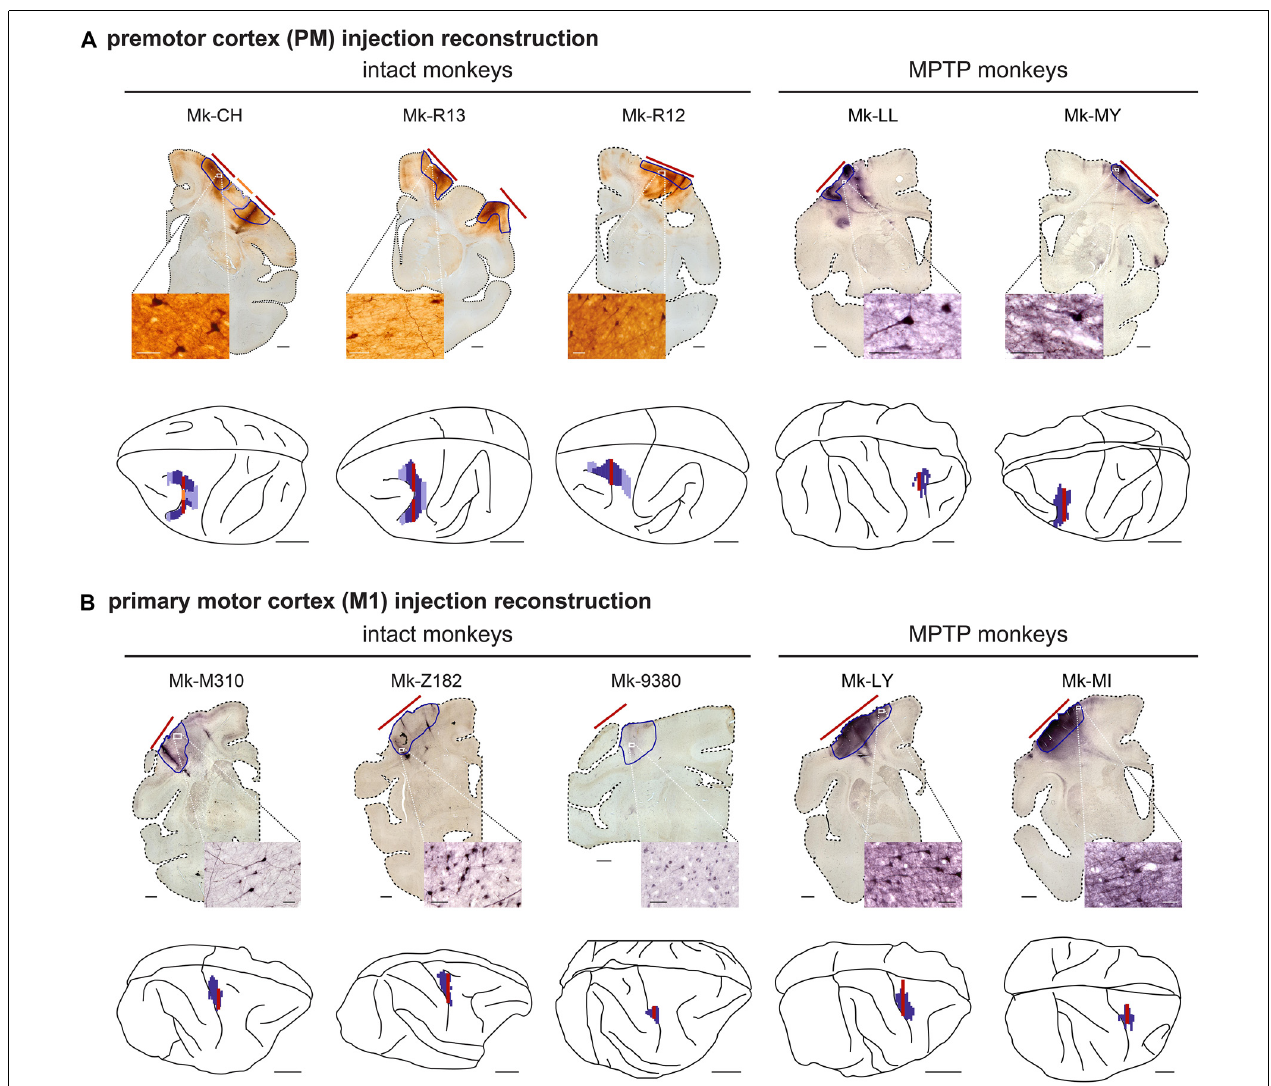
FIGURE 1 | Reconstruction of the biotinylated dextran amine (BDA) injection sites. (A) Reconstruction of the animals injected with BDA in the premotor cortex and (B) for the animals injected in the primary motor cortex (M1). The microphotographs show examples of one histological frontal section, from which the extent of BDA uptake (red lines) are transposed to the 3D brain (red line). Next to each frontal section, the insets show a photomicrograph at high magnification illustrating BDA-labeled cortical neurons in the vicinity of the core of the injection site. Scale bar = 10 mm for the 3D brains, 2 mm for the frontal sections, and 50 µ m for the magnifications microphotographs. Modified from Fregosi et al. (2017,